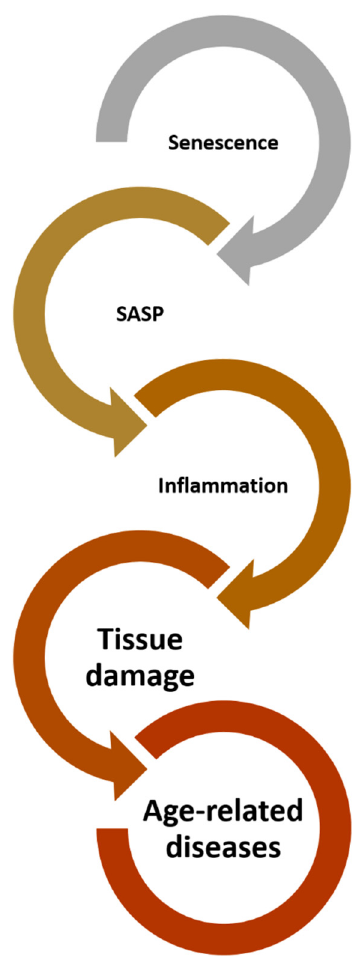
Figure 1. From senescence to age-related diseases. Senescence through components of senescence- associated secretory fenotype (SASP) causes inflammation in tissues and organs which in the end results in occurrence of age-related diseases.